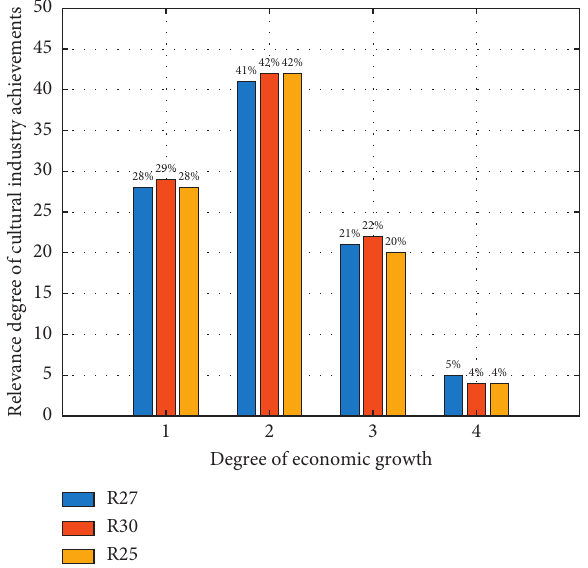
Figure 8: Bar chart of correlation degree between economic benefits and cultural industry